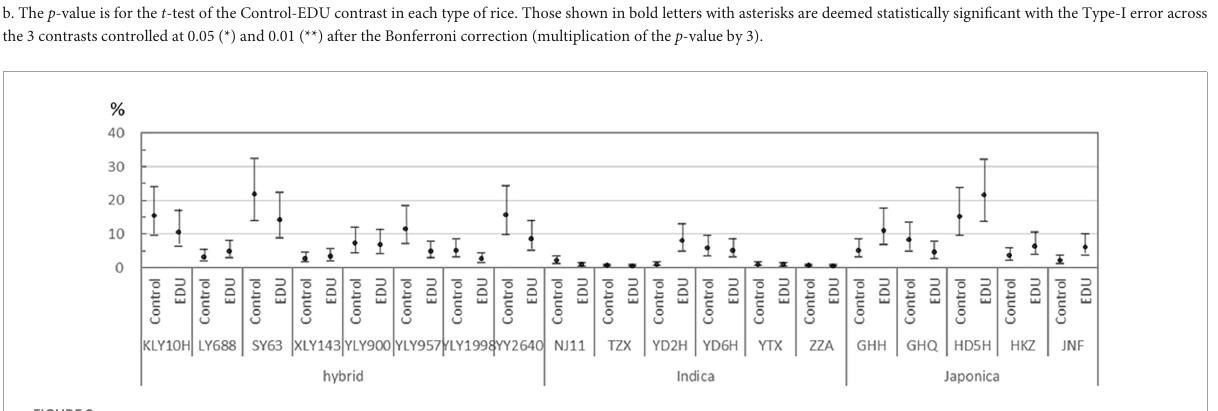
FIGURE2 Fraction of OtCG (other types of chalky grains): an aggregate of white-back, white-base, and white-core grains, for each cultivar of hybrid, indica, and japonica types The least square mean (filled circle) and its 95% confidence interval (short horizontal lines connected with a vertical line) are shown for comparison between EDU and Control treatments. Note that the least-square means and confidence intervals were estimated with the logit-transformed fraction of OtCG, but presented in the original scale (%) herein, which is why the confidence interval is non-uniform across the scale of OtCG